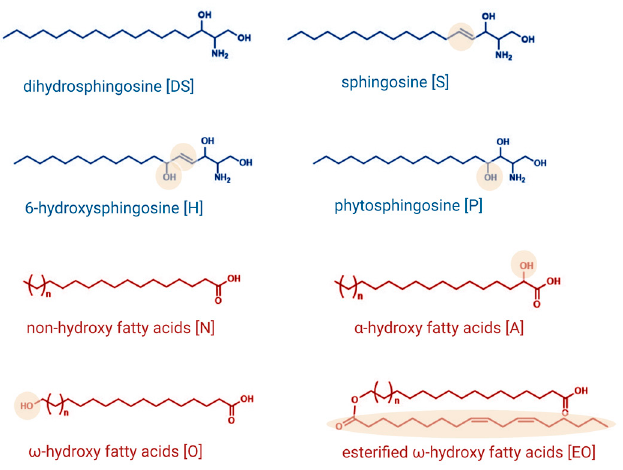
Figure 1. Structures and nomenclature of sphingoid backbones and fatty acids that have been identified to occur at the sphingoid base. Created with BioRender.com.